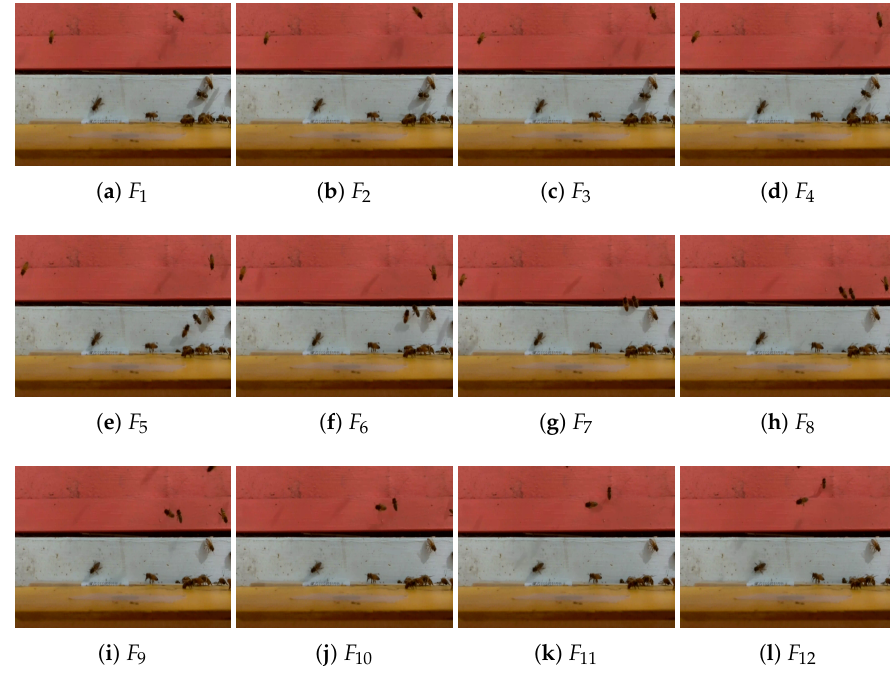
Figure 2. Twelve frames of a video V = ( F 1 , . . . , F 12 )